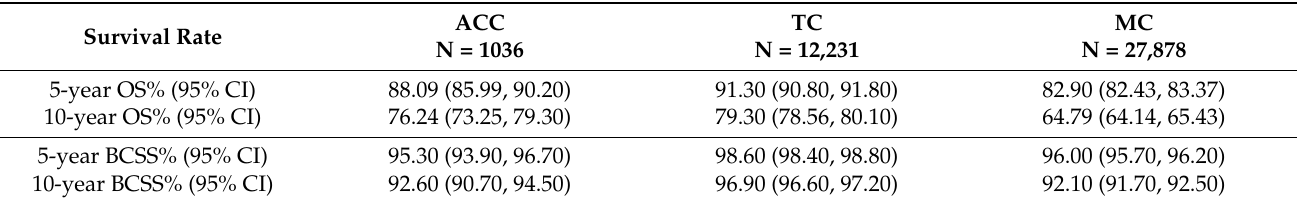
Table 3. Survival (OS and BCSS) rates in patients with ACC, TC and MC of the breast from the SEER database between 1975 and 2019.